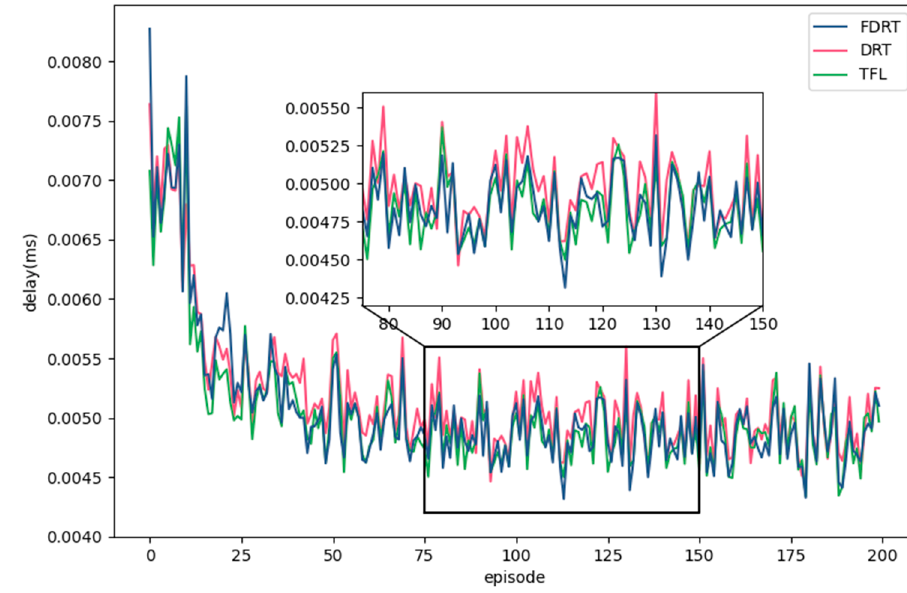
Figure 9. Comparison of average task execution delay of FDRT, DRT, and TFL.